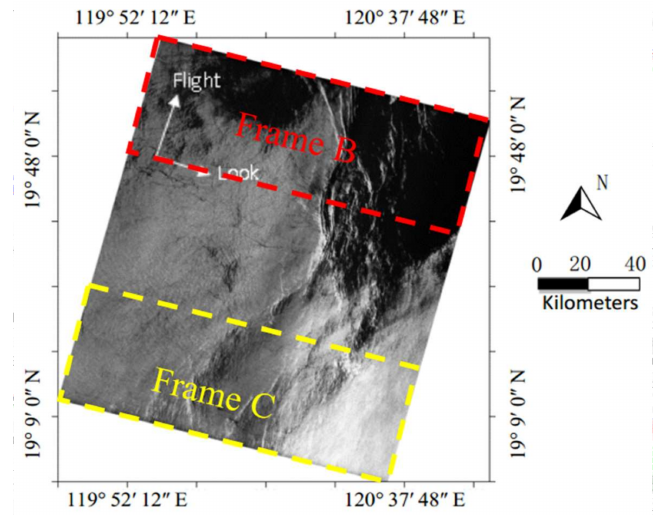
Figure 9. ERS-2 SAR ocean image of South China Sea collected on 30 April 2005, at 02:28 UTC.